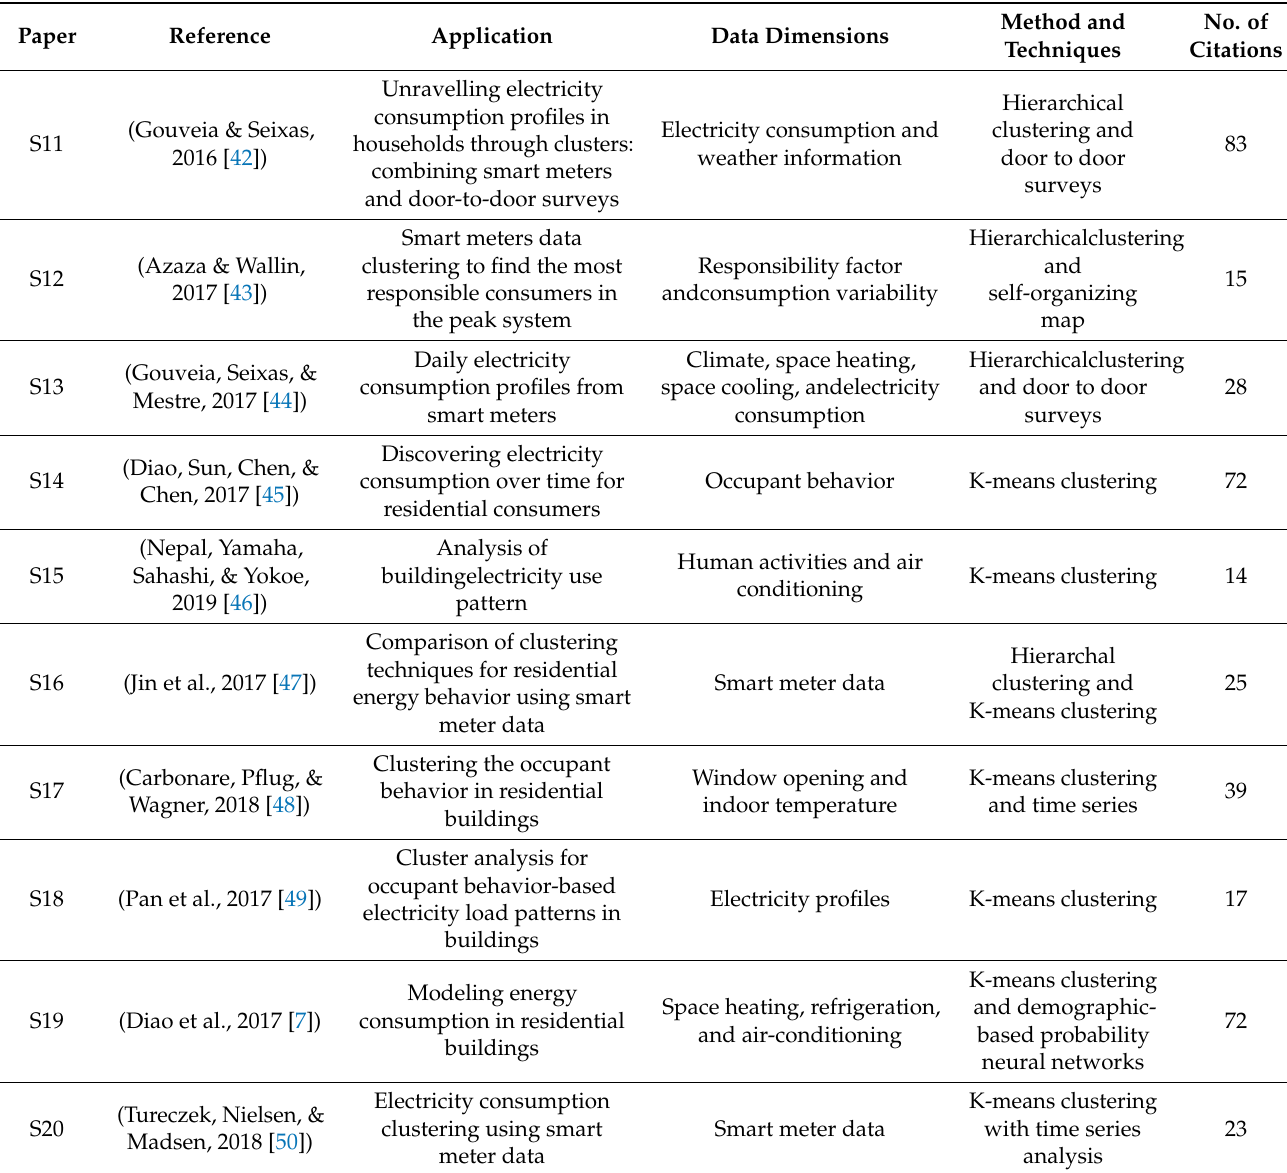
Table 2. Summary of papers in the category of classification of energy consumption of